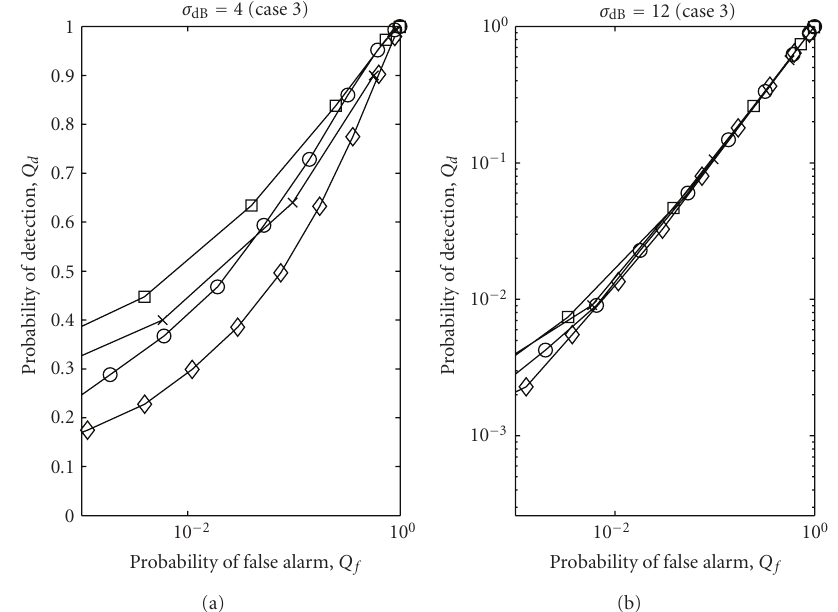
Figure 10: Receiver operating characteristics for 5 collaborating users in spatially correlated shadowing fading (Case 1: all users have similar SNR).